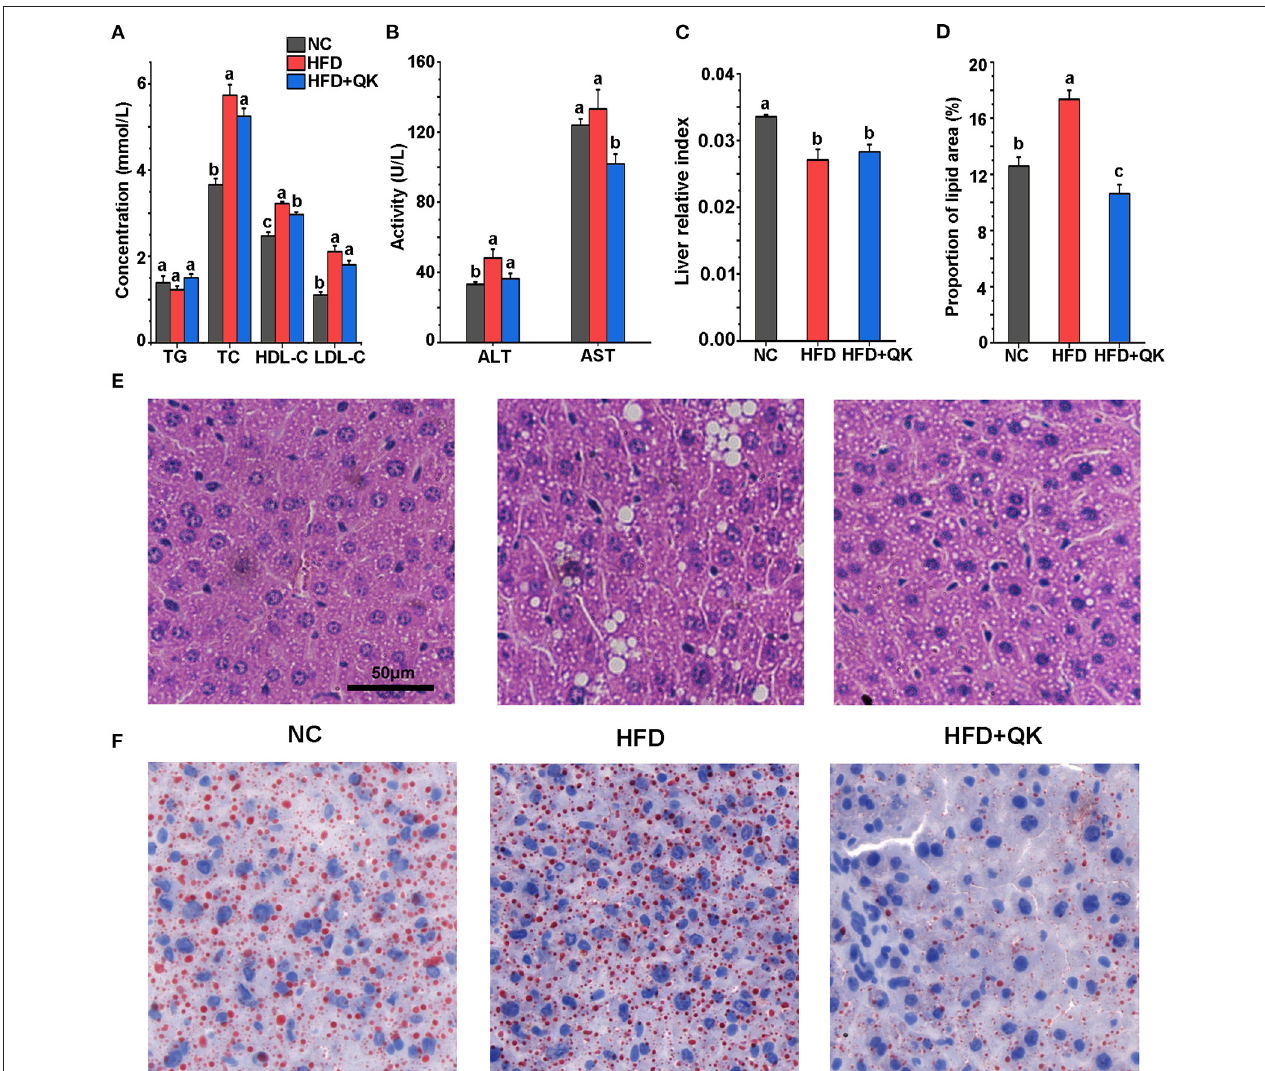
FIGURE 2 | Effects of WGQK on serum lipid parameters, liver function indicators, and histology. (A) Mean concentration of total triglyceride (TG), total cholesterol (TC), high-density lipoprotein cholesterol (HDL-C), and low-density lipoprotein cholesterol (LDL-C) in the serum mice of each group; (B) Mean serum glutamic-pyruvic transaminase (ALT) and glutamic oxalacetic transaminase (AST) levels; (C) Liver relative index of each group; (D) Mean proportion of lipid area of five different visual fields of each group (calculated by Image J); (E) Representative photomicrographs of H&E-stained sections of the liver of each group mice showing white lipid droplets (400 × magnification). (F) Representative photomicrographs of oil-red stained sections of the liver (400 × magnification), red represent lipid droplets. Data are presented as mean ± SD ( n = 5). Significant difference was determined using an unpaired two-tailed t -test, different superscript letters of any two means represent significant differences ( p <